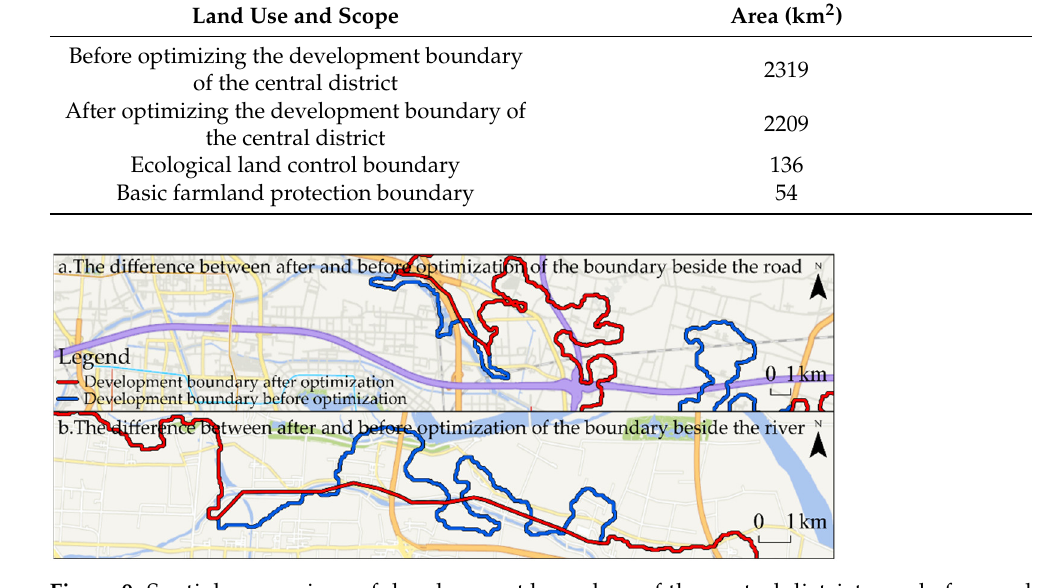
Figure 9. Spatial comparison of development boundary of the central district area before and after optimization.